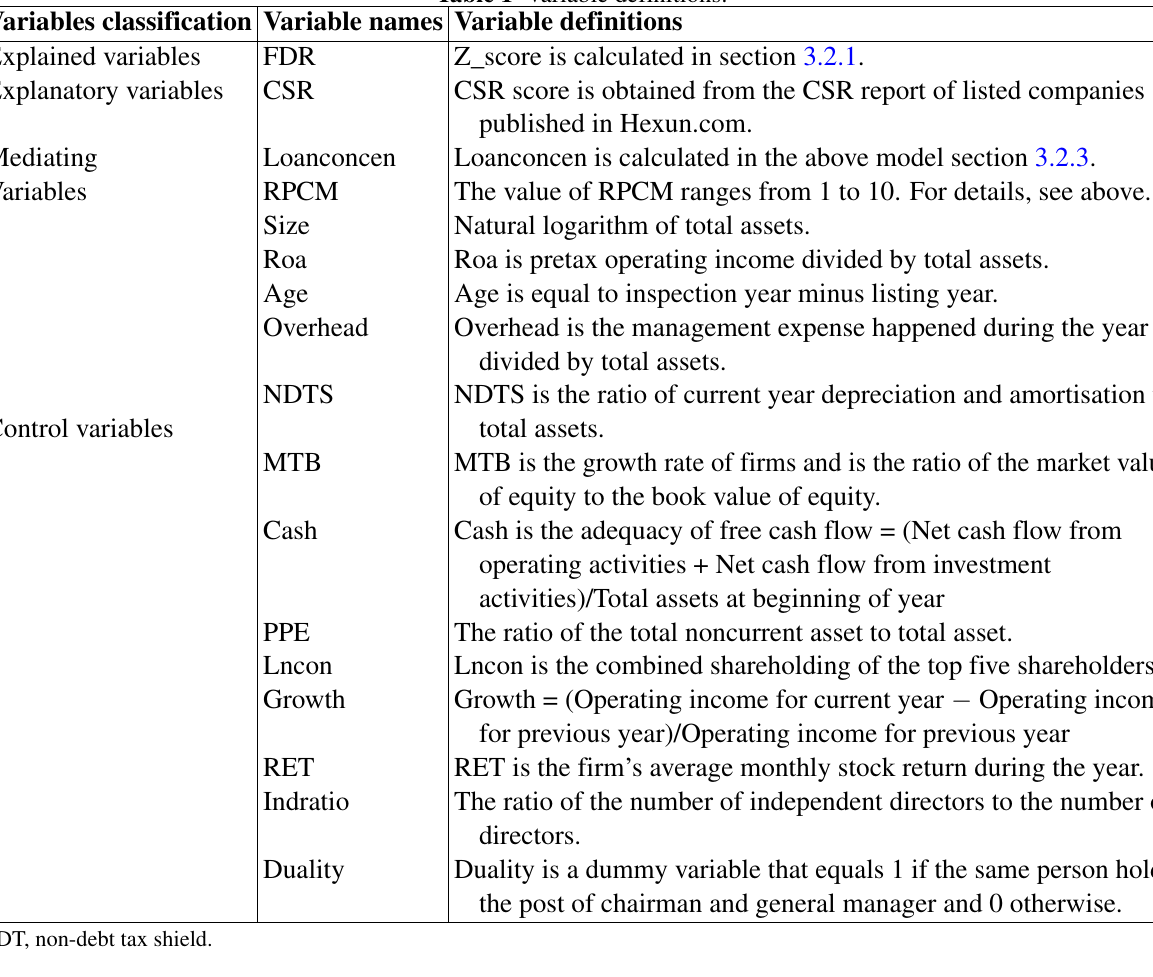
Table 1 Variable